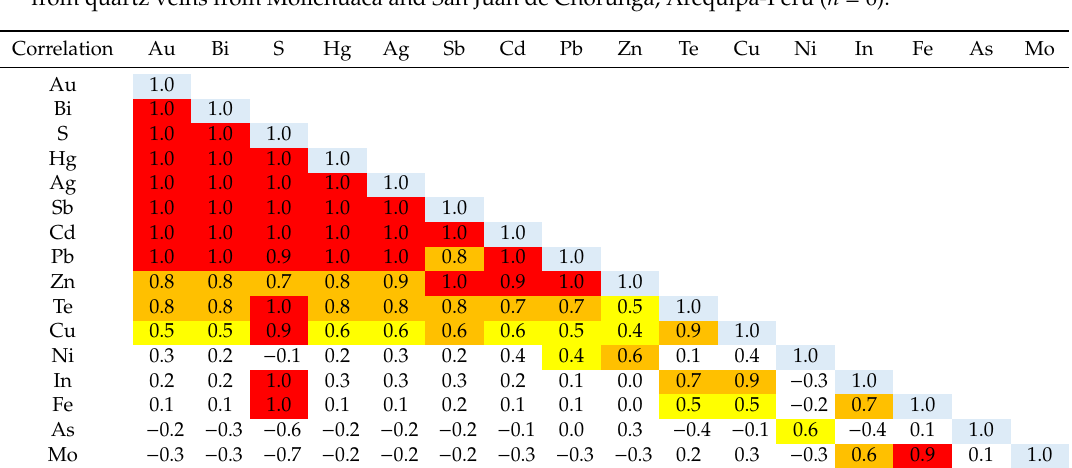
Table 2. Correlation matrix between Au, Bi, S, Hg, Ag, Sb, Cd, Pb, Zn, Te, Cu, Ni, In, Fe, As, and Mo from quartz veins from Mollehuaca and San Juan de Chorunga, Arequipa-Per ú ( n =